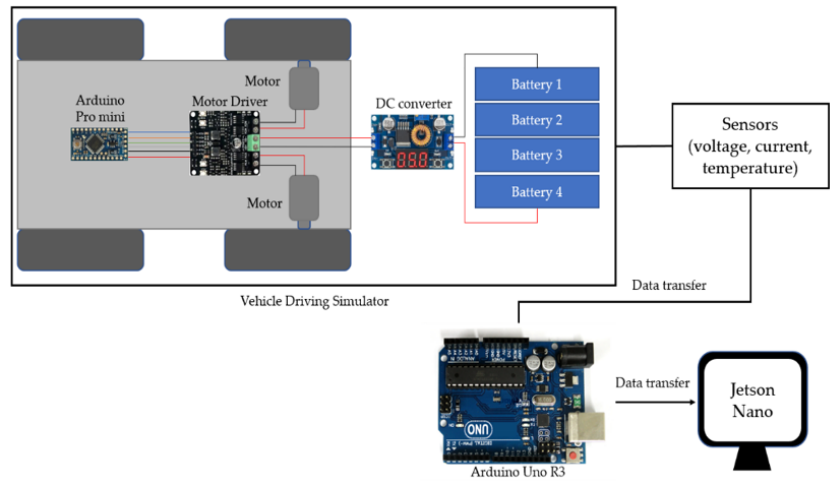
Figure 1. Configuration of the overall system based on the vehicle-driving simulator and Jetson Nano device.